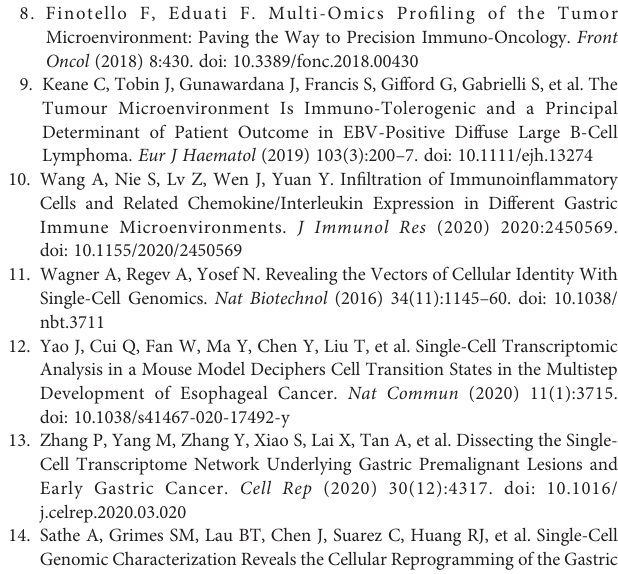
Supplementary Figure 1 | Distribution of gene numbers and gene expression pro fi les of all single-cell sequencing data, dimensionality reduction, and elimination of batch effects. (A) The relationship between the percentage of mitochondrial genes and mRNA reads, and the relationship between mRNA levels. (B) Scatterplot illustrating UMI, number of genes, and the percentage of mitochondrial genes in each cell at the four stages. (C) Before removing batch effect between batches;